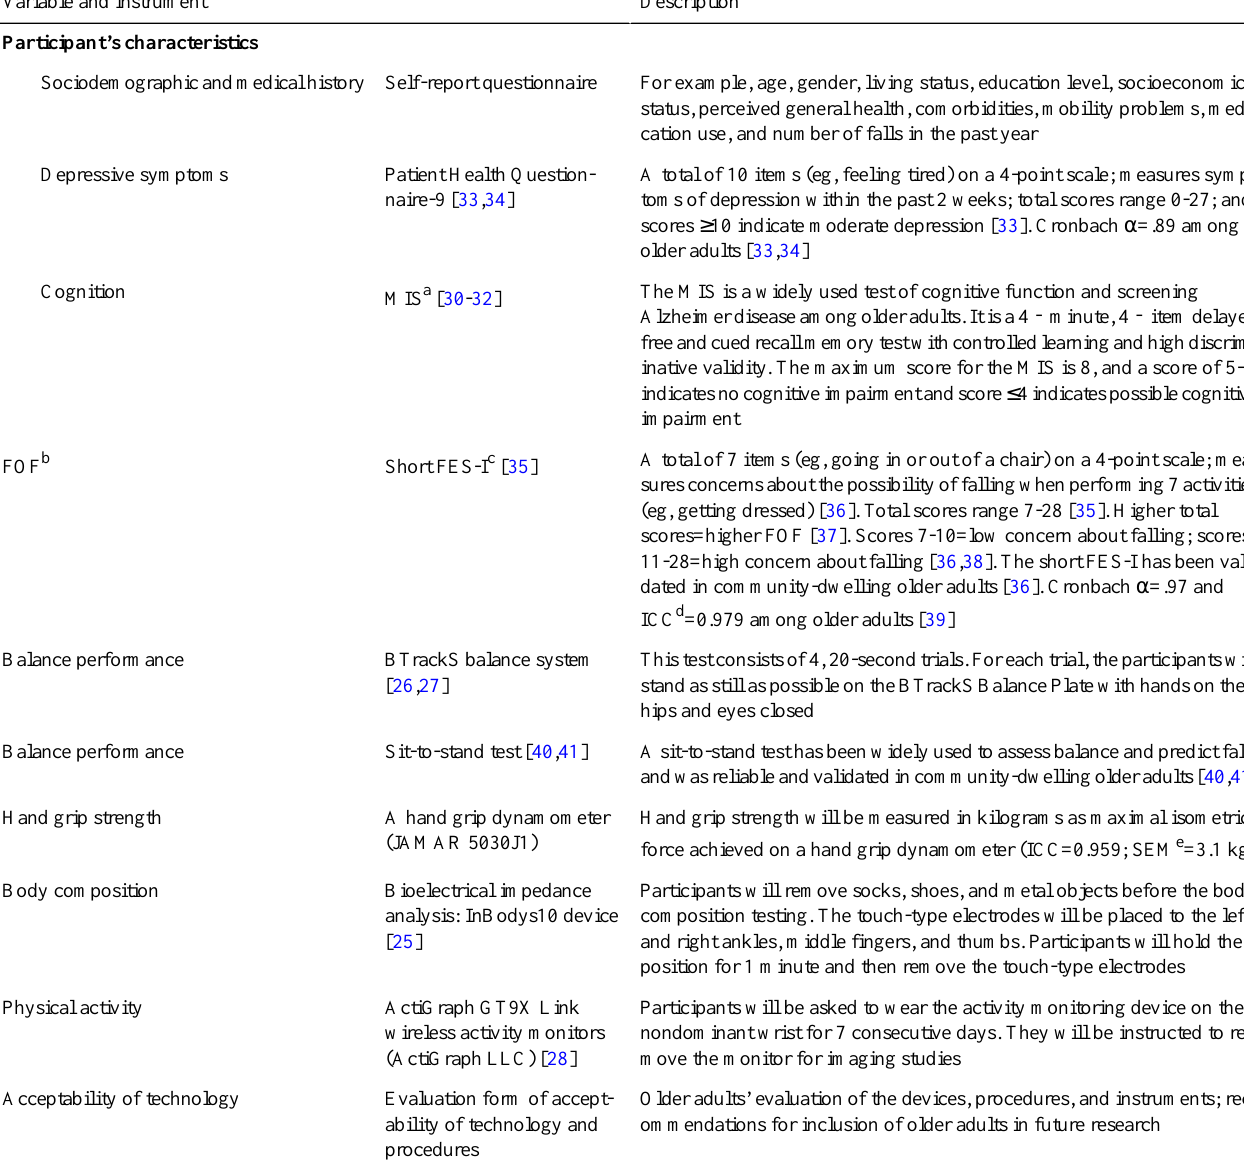
Table 1. Description of study variables and